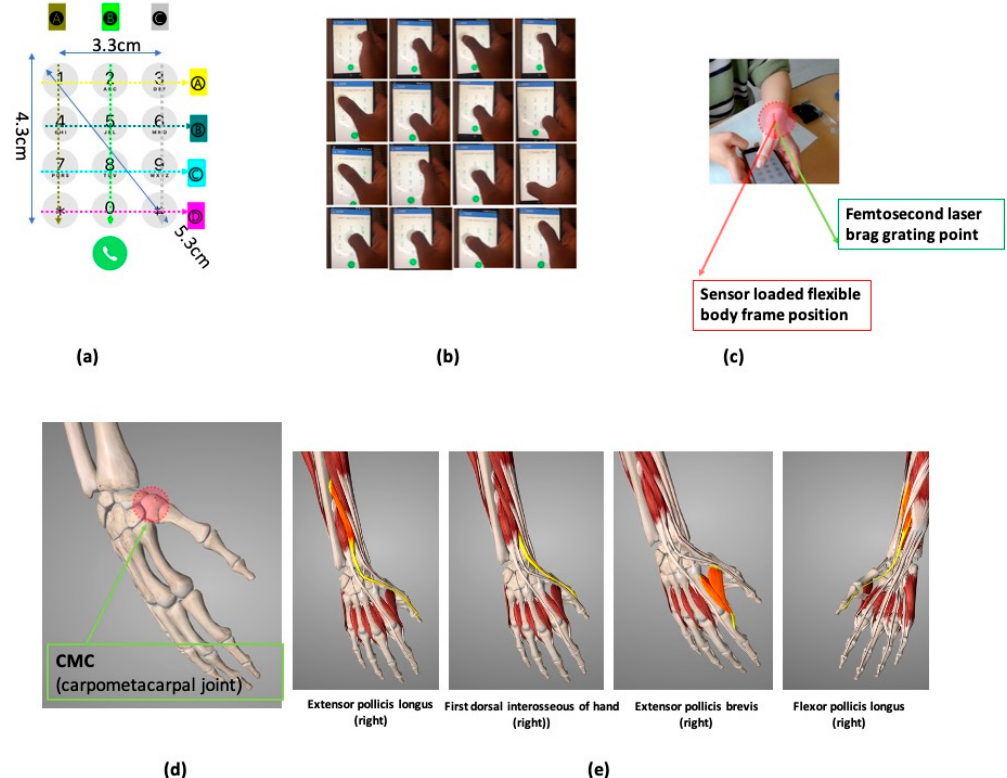
Figure 5. ( a ) mobile phone numbering coordinate standard; ( b ) real photo of the cell phone numbering experiment; and ( c ) sensor-wearing method and experiment method photo. ( d ) carpometacarpal (CMC) joint ( e ) constrictor muscle combined with rotation of the CMC joint.